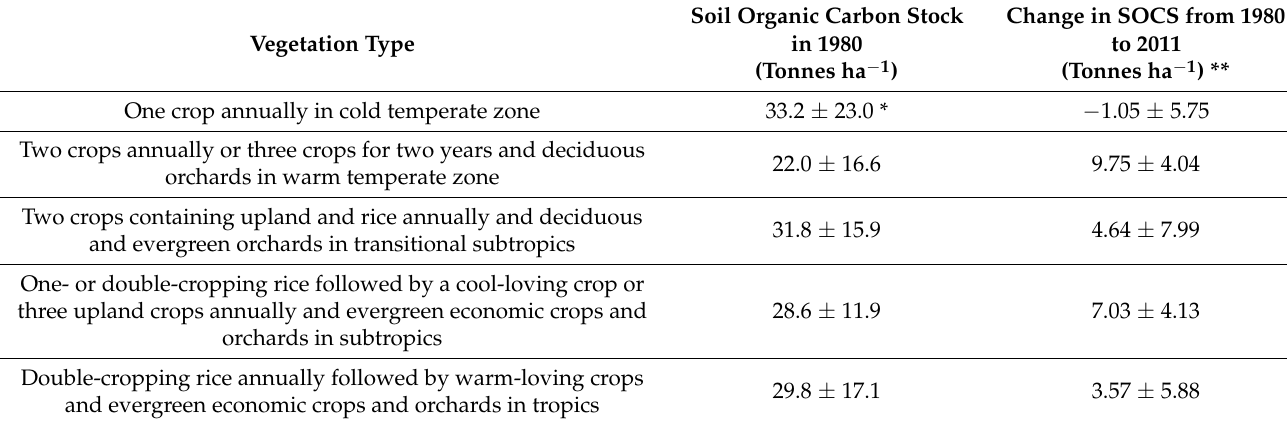
Figure 3. Soil organic carbon stock in the 0–20 cm layer of cultivated land in 1980 in China. Table 1. Changes in the soil organic carbon stock in the 0–20 cm layer of cultivated land from 1980 to 2011 in China.